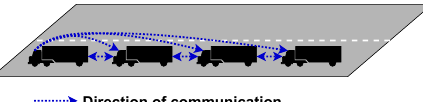
Figure 8. Bidirectional-leader topology of platooning communications.